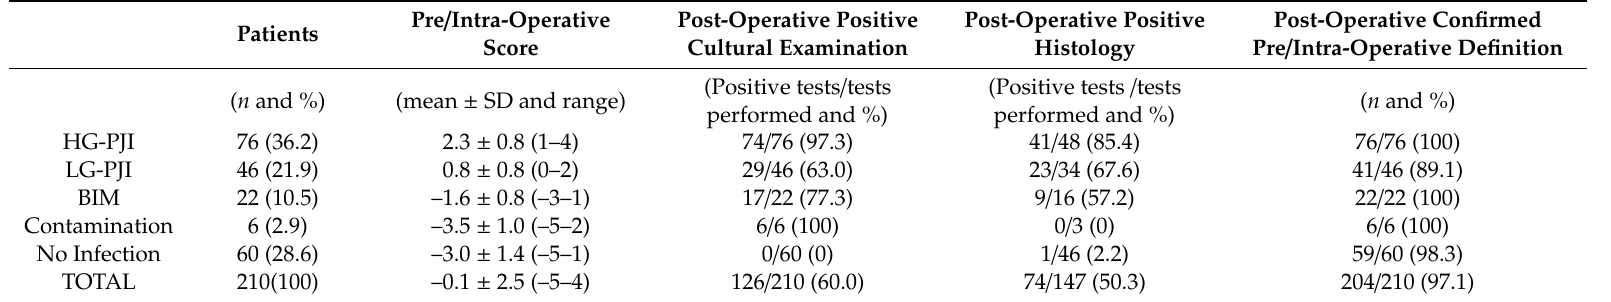
Table 6. Pre / Intra-operative patients’ classification and post-operative confirmatory results.